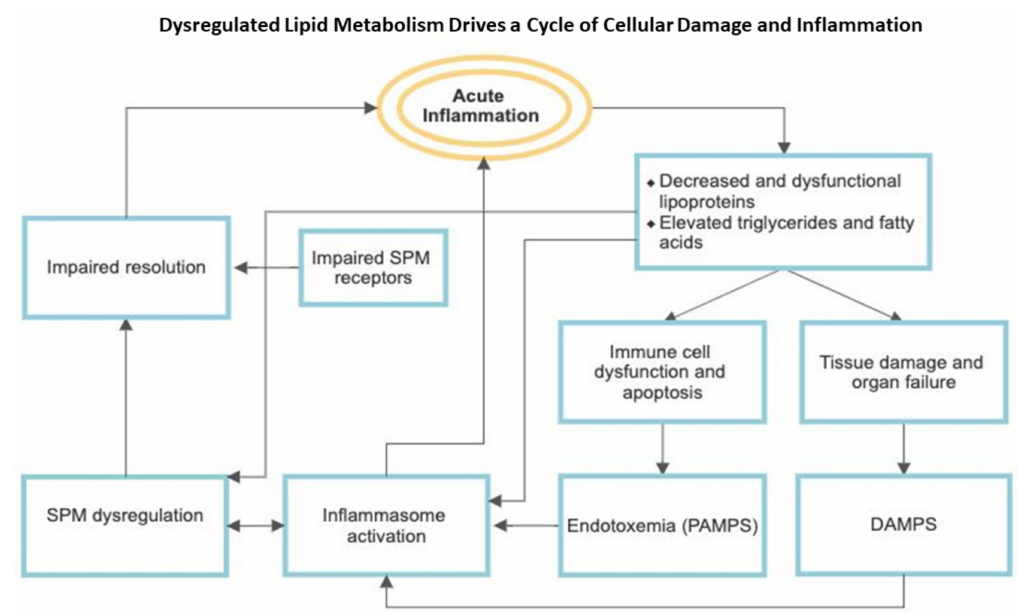
Figure 2. Dysfunctional HDL (Dys HDL) fails to regulate and actively impairs the innate immune response (see Figure 1). Elevations in triglycerides and fatty acids, which have innate signaling properties contribute to this impairment. This leads to tissue damage, organ failure, and immune cell dysfunction. These factors contribute to complex interactions between sustained inflammasome activation and dysregulated lipid pro-resolving mediators, maintained by low grade endotoxemia and DAMPs, leading to an inappropriate inflammatory response. SPMs, specialized pro-resolving mediators; PAMPs, pathogen-associated molecular patterns; DAMPs, damage-associated molecular